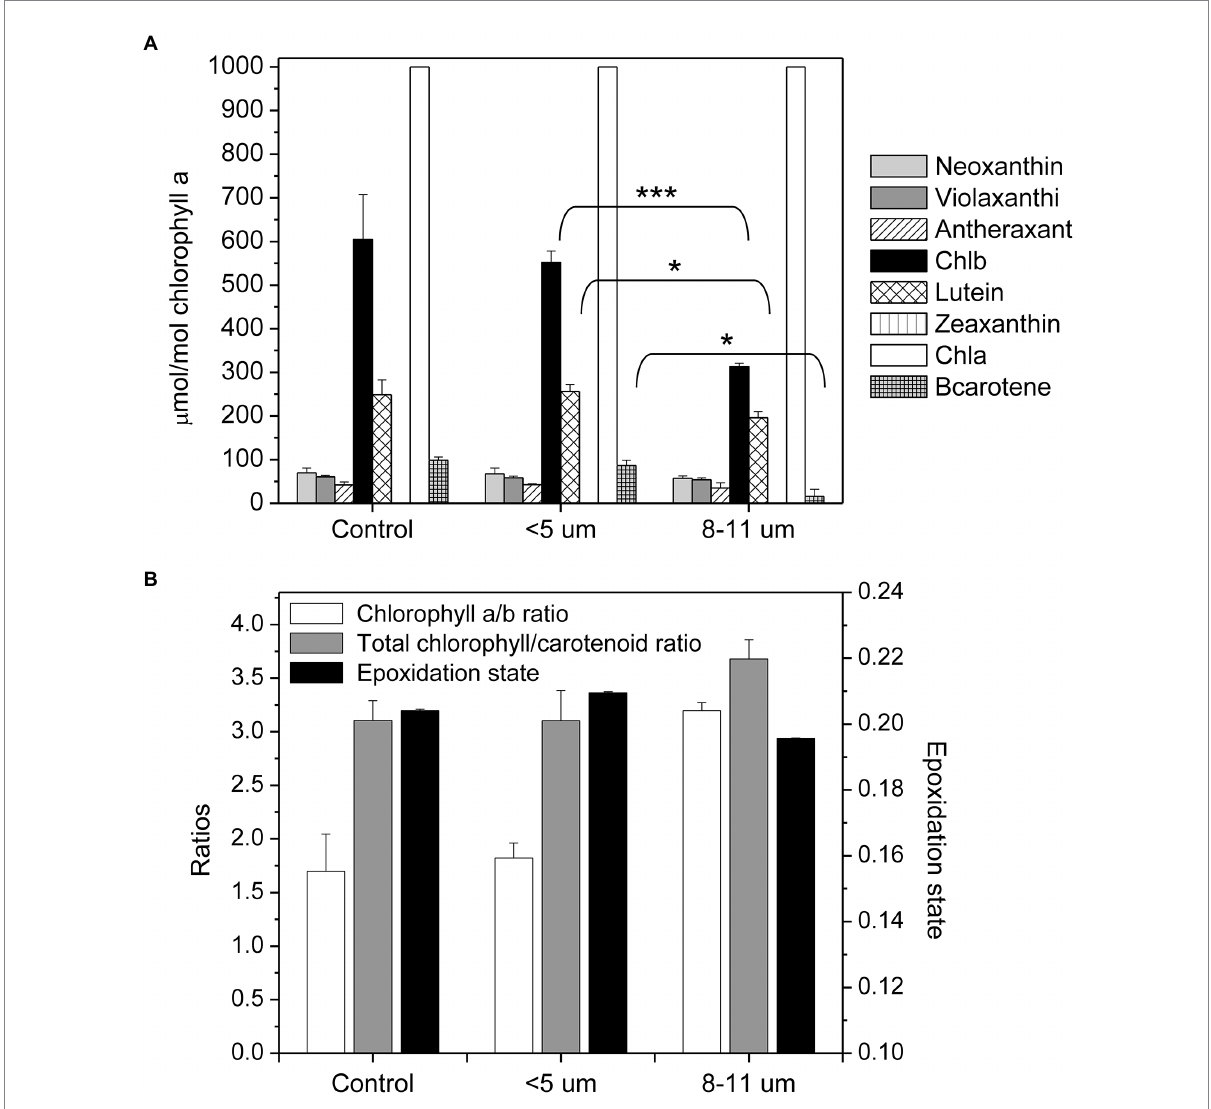
FIGURE 8 Composition of photosynthetic pigments in control and separated cell fractions of C. priscuii based on size (A) . Pigment concentrations are expressed as μ mol per mole of chlorophyll a. Mean values between single cells and palmelloids were analyzed by an unpaired t-test, with the following significance levels: *significant at p < 0.05, **significant at p < 0.005, and ***significant at p < 0.001. No asterisk indicates no significance. Analysis of chlorophyll a/b ratios, total chlorophyll (a + b) to total carotenoid pool and epoxidation states (mean ± SE; B